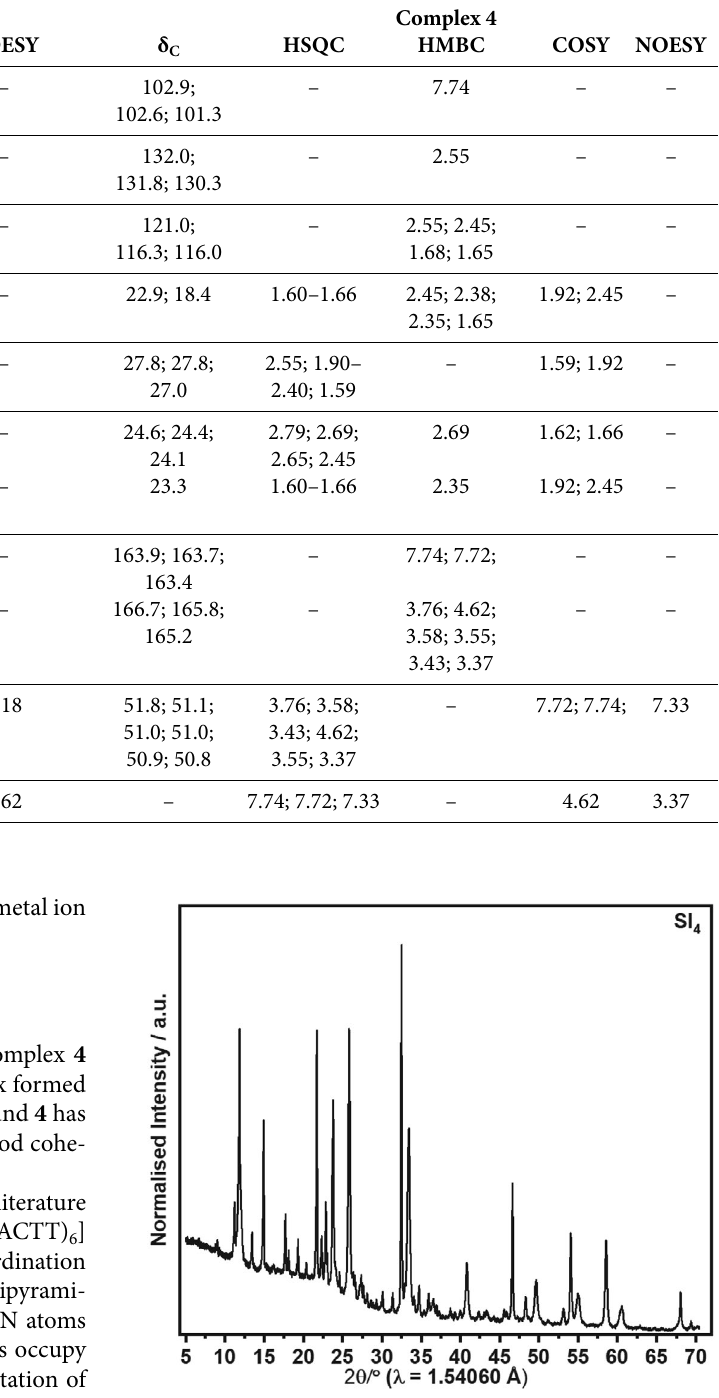
Figure 4. Powder XRD patterns of complex 4